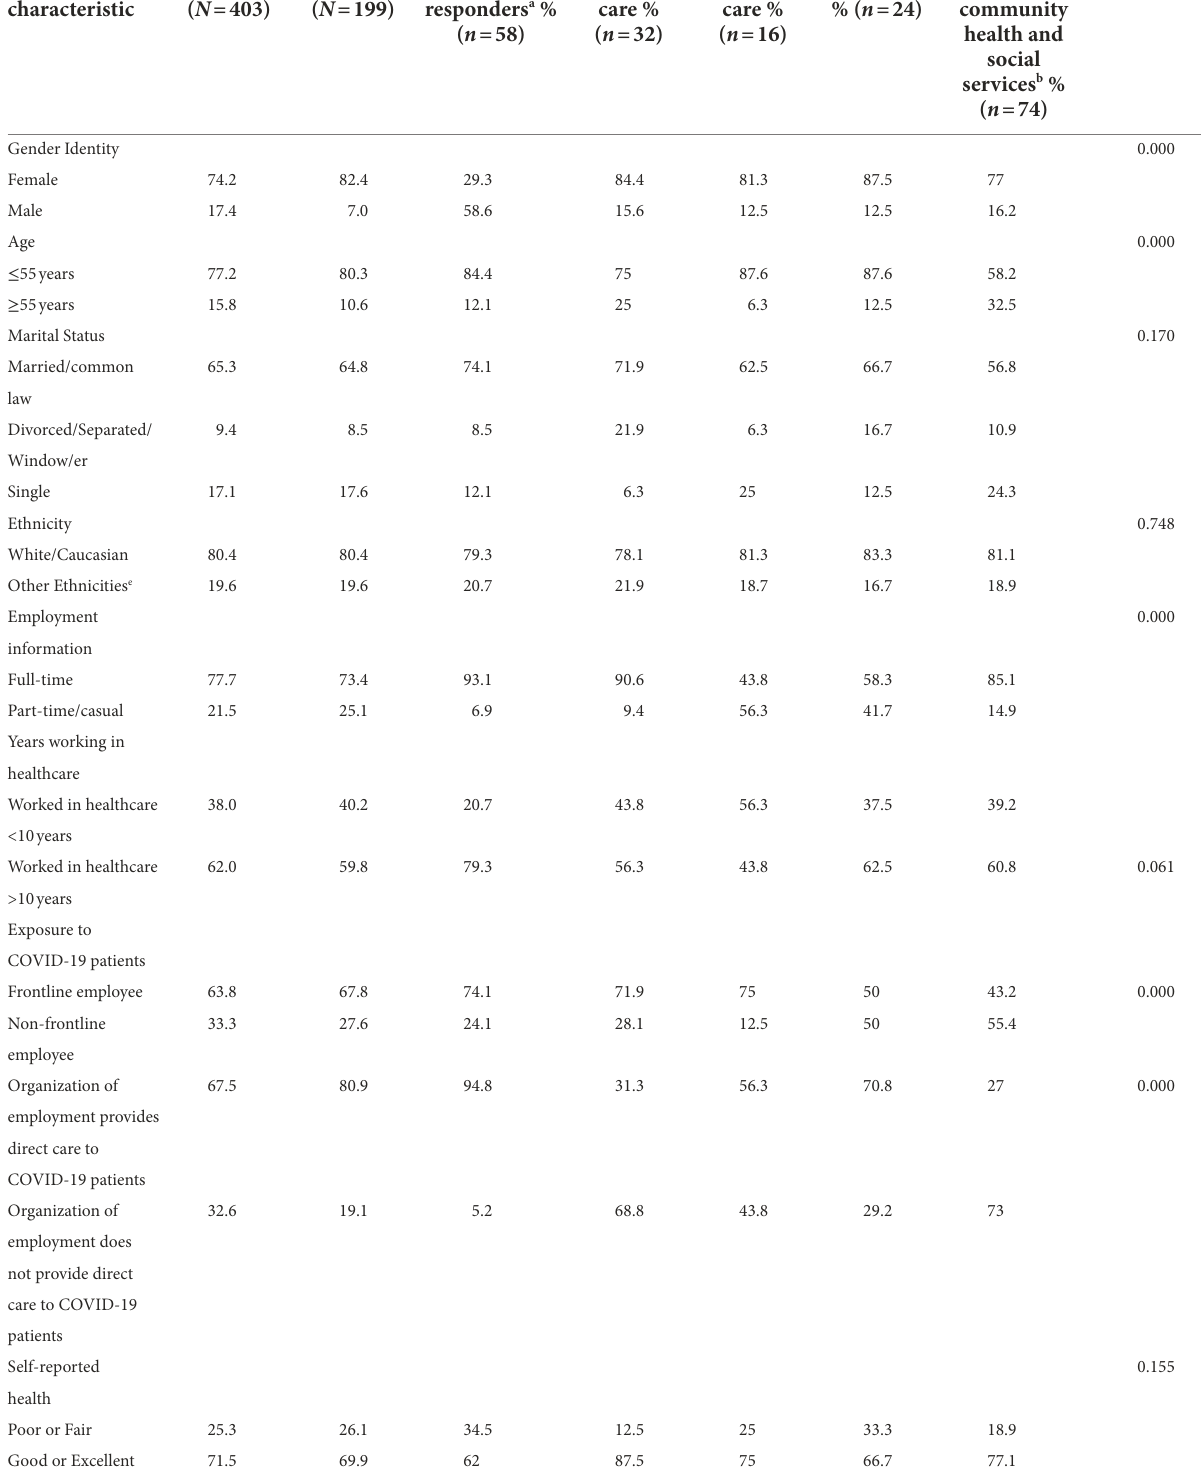
TABLE 1 Sociodemographic and employment characteristics for overall overall sample and by healthcare setting. Study characteristic